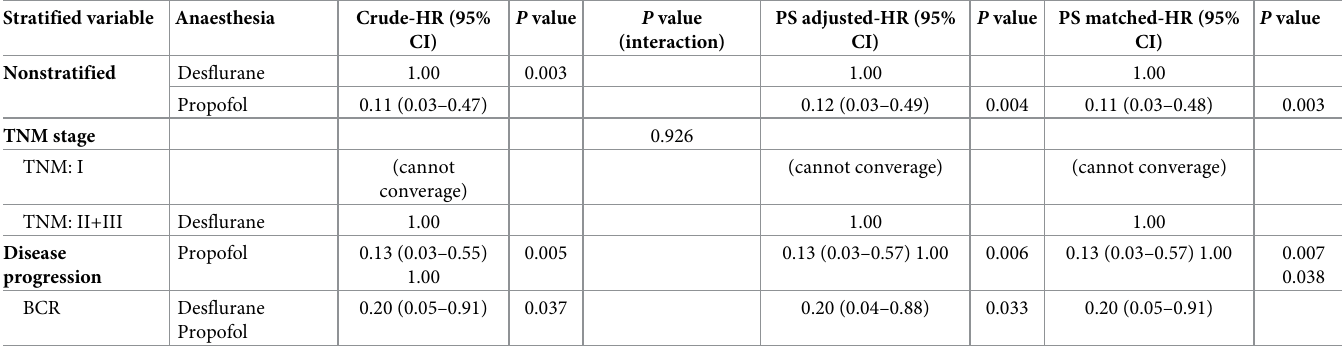
Table 3. Subgroup analyses for TNM stage and disease